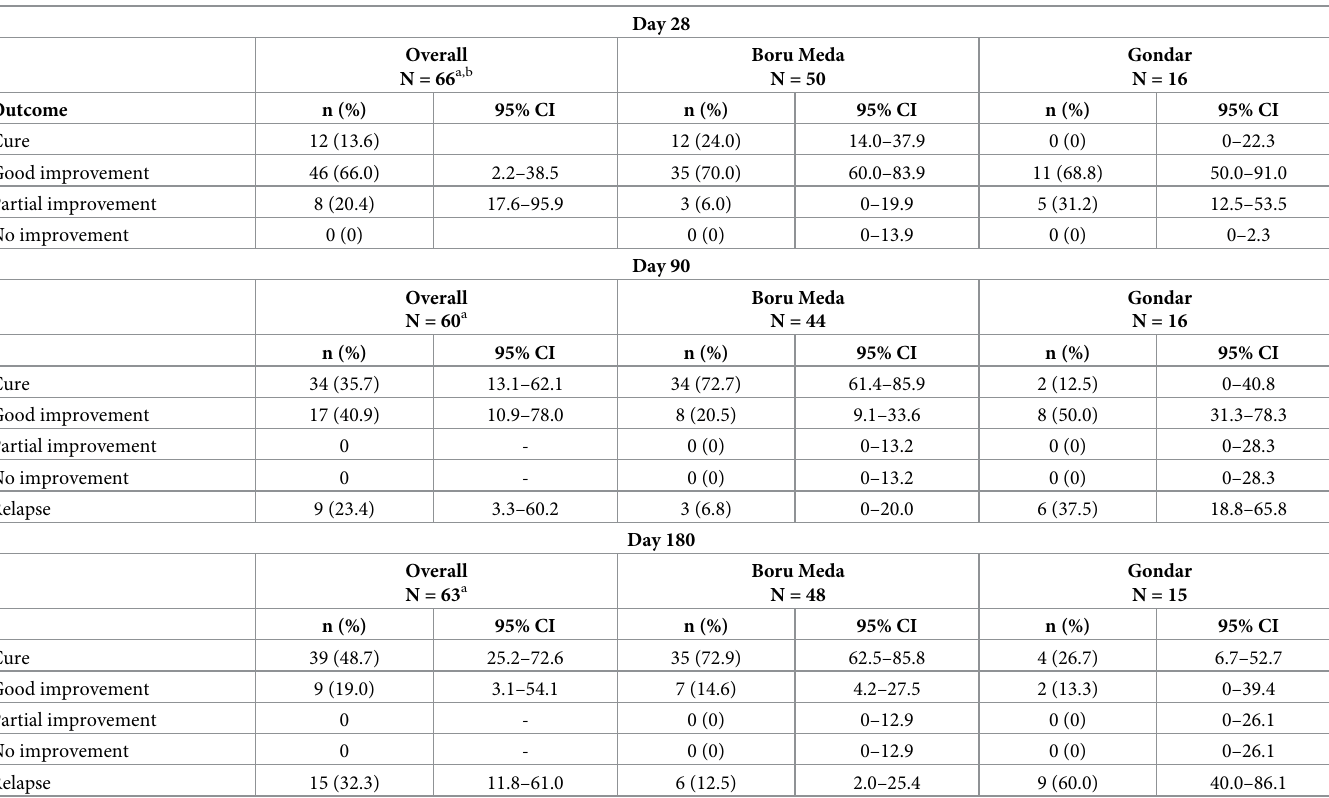
Table 3. Miltefosine treatment outcomes.